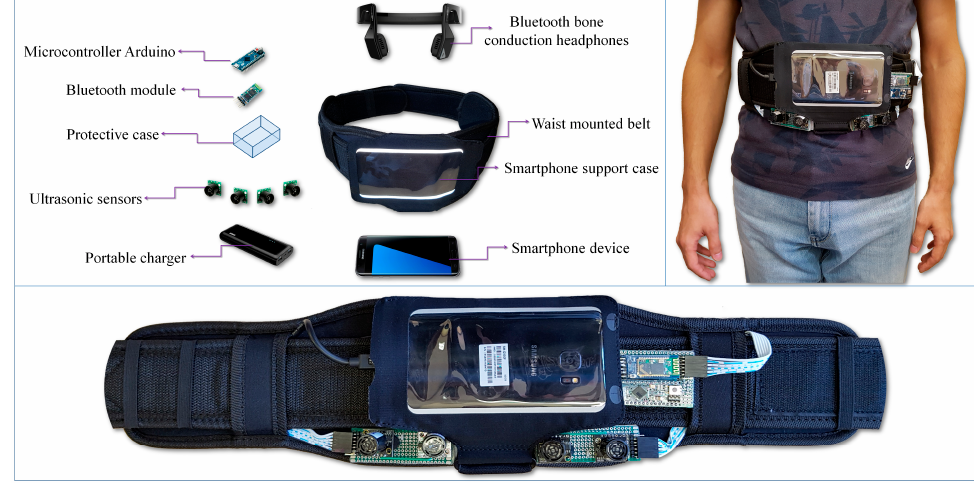
Figure 1. The hardware architecture of the proposed framework.